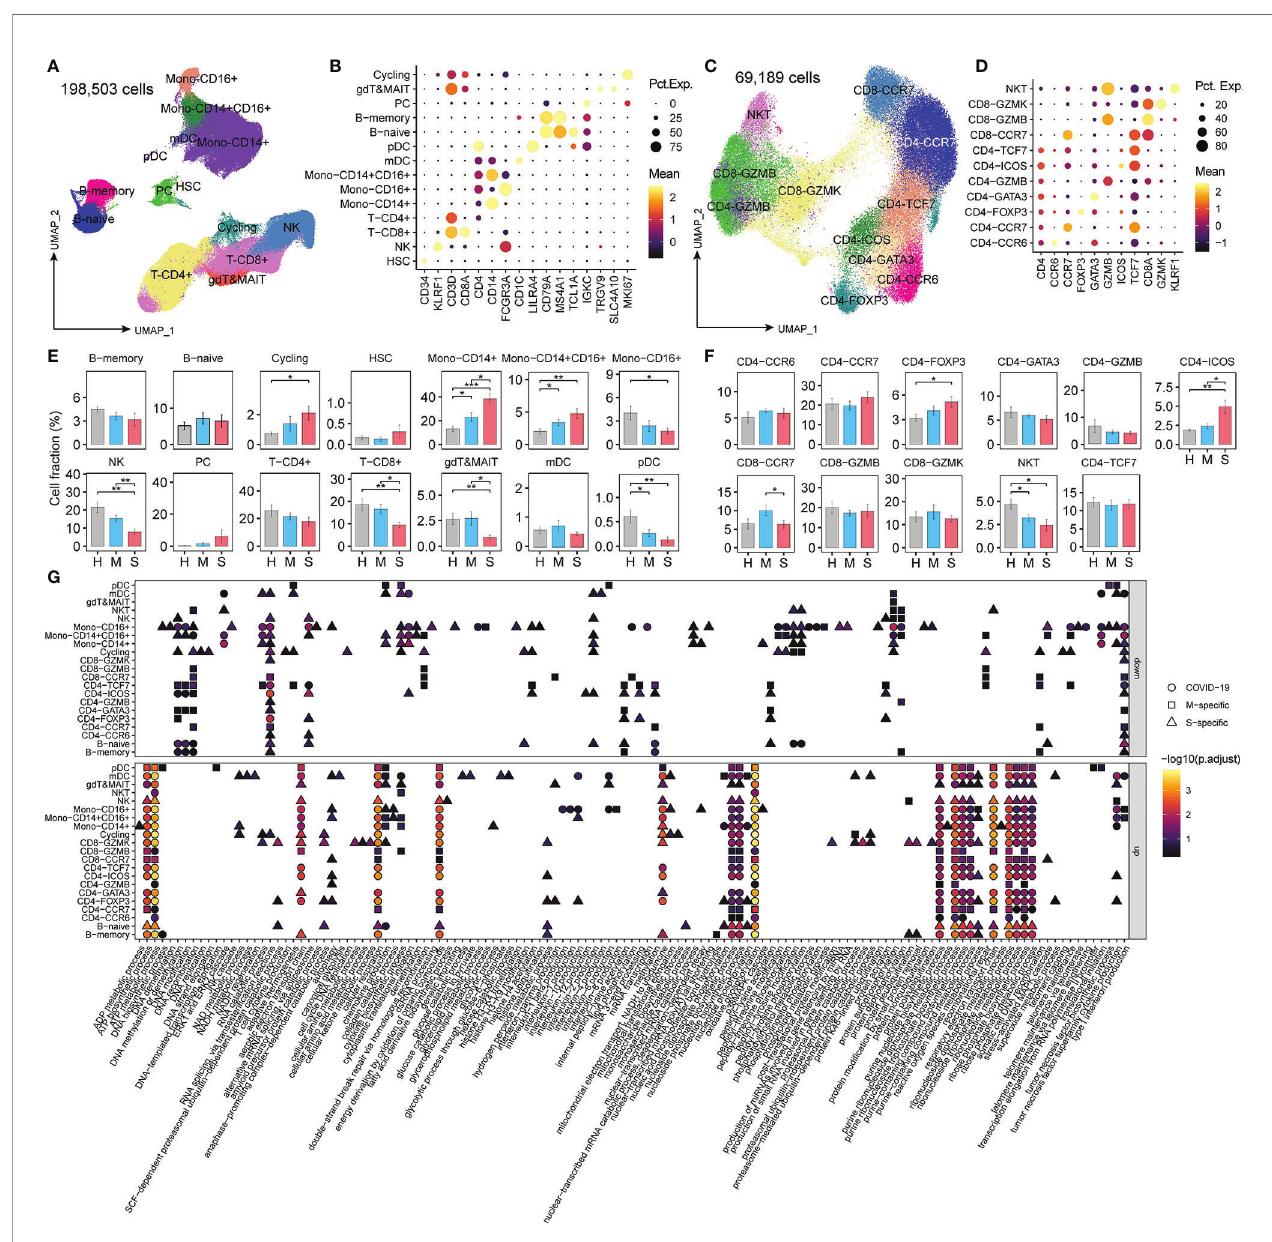
FIGURE 1 | The changed metabolic processes in PBMCs from COVID-19 patients. (A, C) Clustering of PBMCs among all cells and T cells, respectively, in COVID- 19 patients; (B, D) Canonical markers for cell cluster annotation. “ Mean ” indicates the average gene expression levels. “ Pct.Exp. ” indicates the percentage of cells expressing the corresponding genes. (E, F) The proportion of each cluster in COVID-19 patients. Student ’ s t-test; * P < 0.05; ** P < 0.01; *** P < 0.001. (G) The signi fi cantly enriched child terms of metabolic processes (GO:0008152) in each cell type using genes differentially expressed in patients with mild or severe disease compared to healthy controls (MAST algorithm; P <0.01, logFC > 0.25 or logFC < -0.25). M-speci fi c: the unique GO terms enriched with DEGs found in patients with mild disease compared to healthy controls. S-speci fi c: the unique GO terms enriched with DEGs found in patients with severe disease compared to healthy controls. COVID-19: GO terms enriched with DEGs found in both mild and patients with severe disease compared to healthy